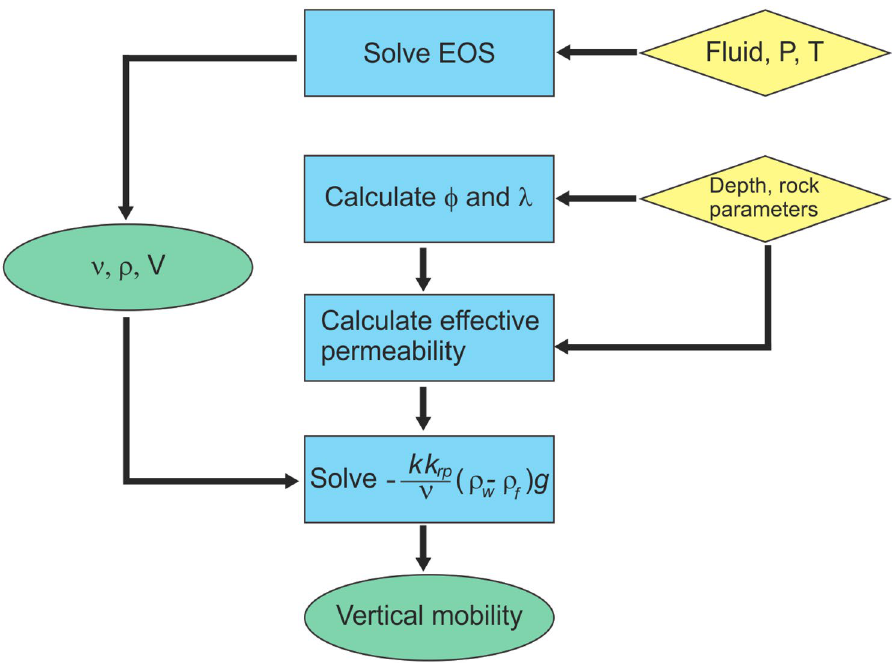
Figure 1. Methodology to calculate vertical mobility of fluids. Diamonds = inputs, rectangles = processes, ovals = outputs.